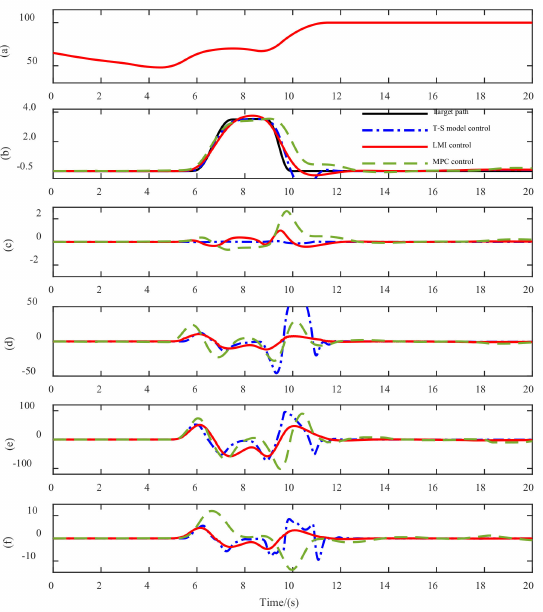
Figure 4. ( a ) Speed (km/h), ( b ) lateral displacement (m), ( c ) deviation (m), ( d ) steering torque control input (Nm), ( e ) steering angle ( ◦ ), and ( f ) yaw rate ( ◦